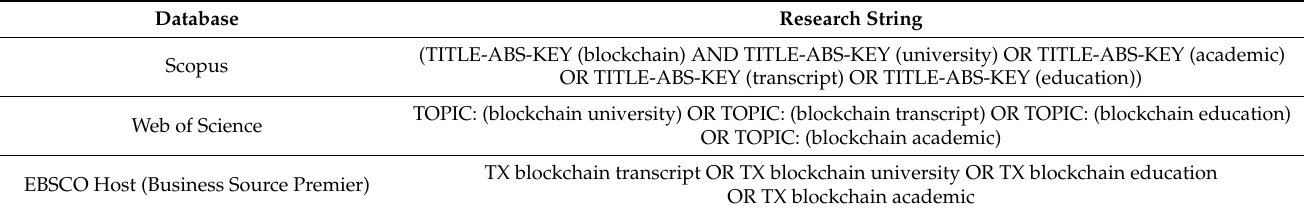
Table 1. Research String/Database.